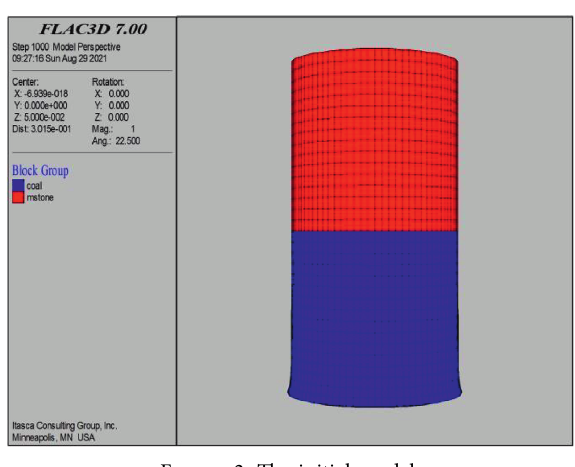
Figure 2: The initial model. Table 1: The thicknesses and parameters of the coal seams and rock strata.